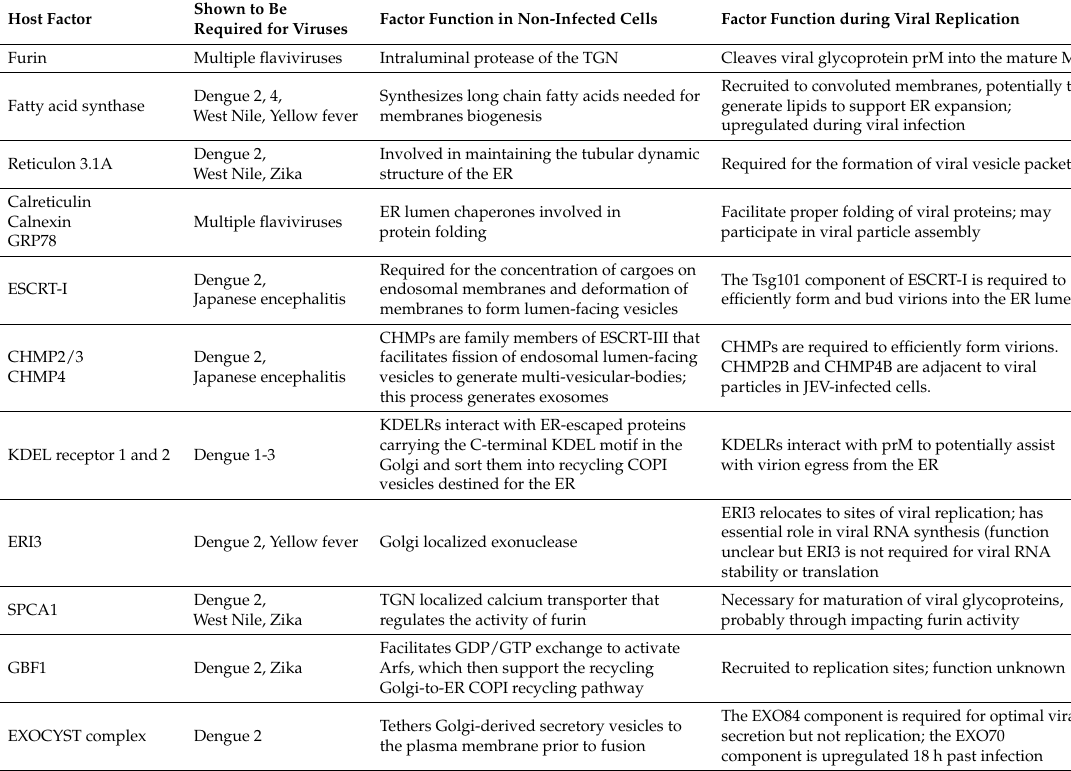
Table 1. Host secretory and membrane trafficking factors involved in Flavivirus life